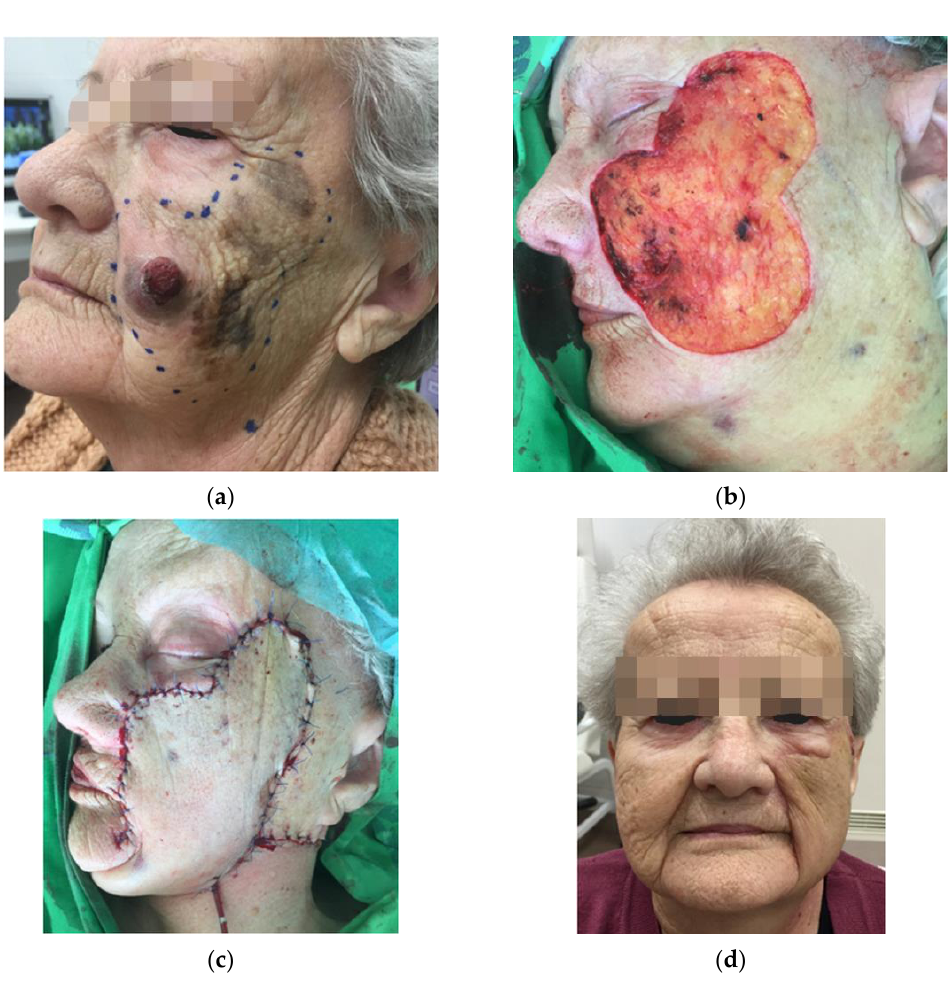
Figure 3. ( a ) Locally advanced LMM and NMM of the cheek preoperatively. ( b ): Defect after primary tumor excision; ( c ) immediate postoperative picture; ( d ): six-month follow-up.